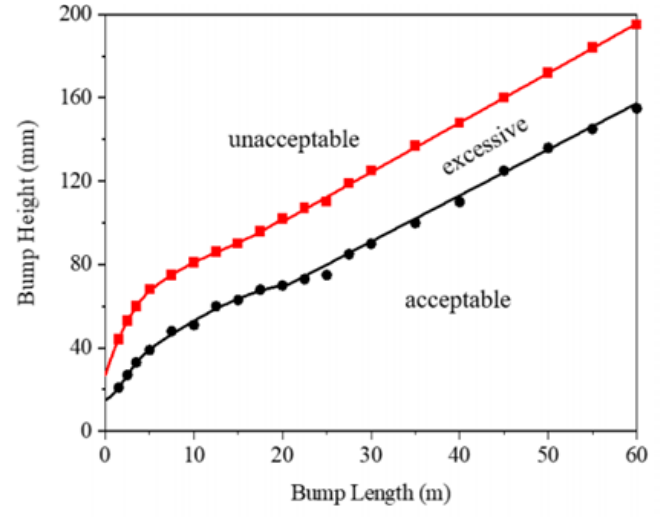
Figure 11. Modification of Boeing